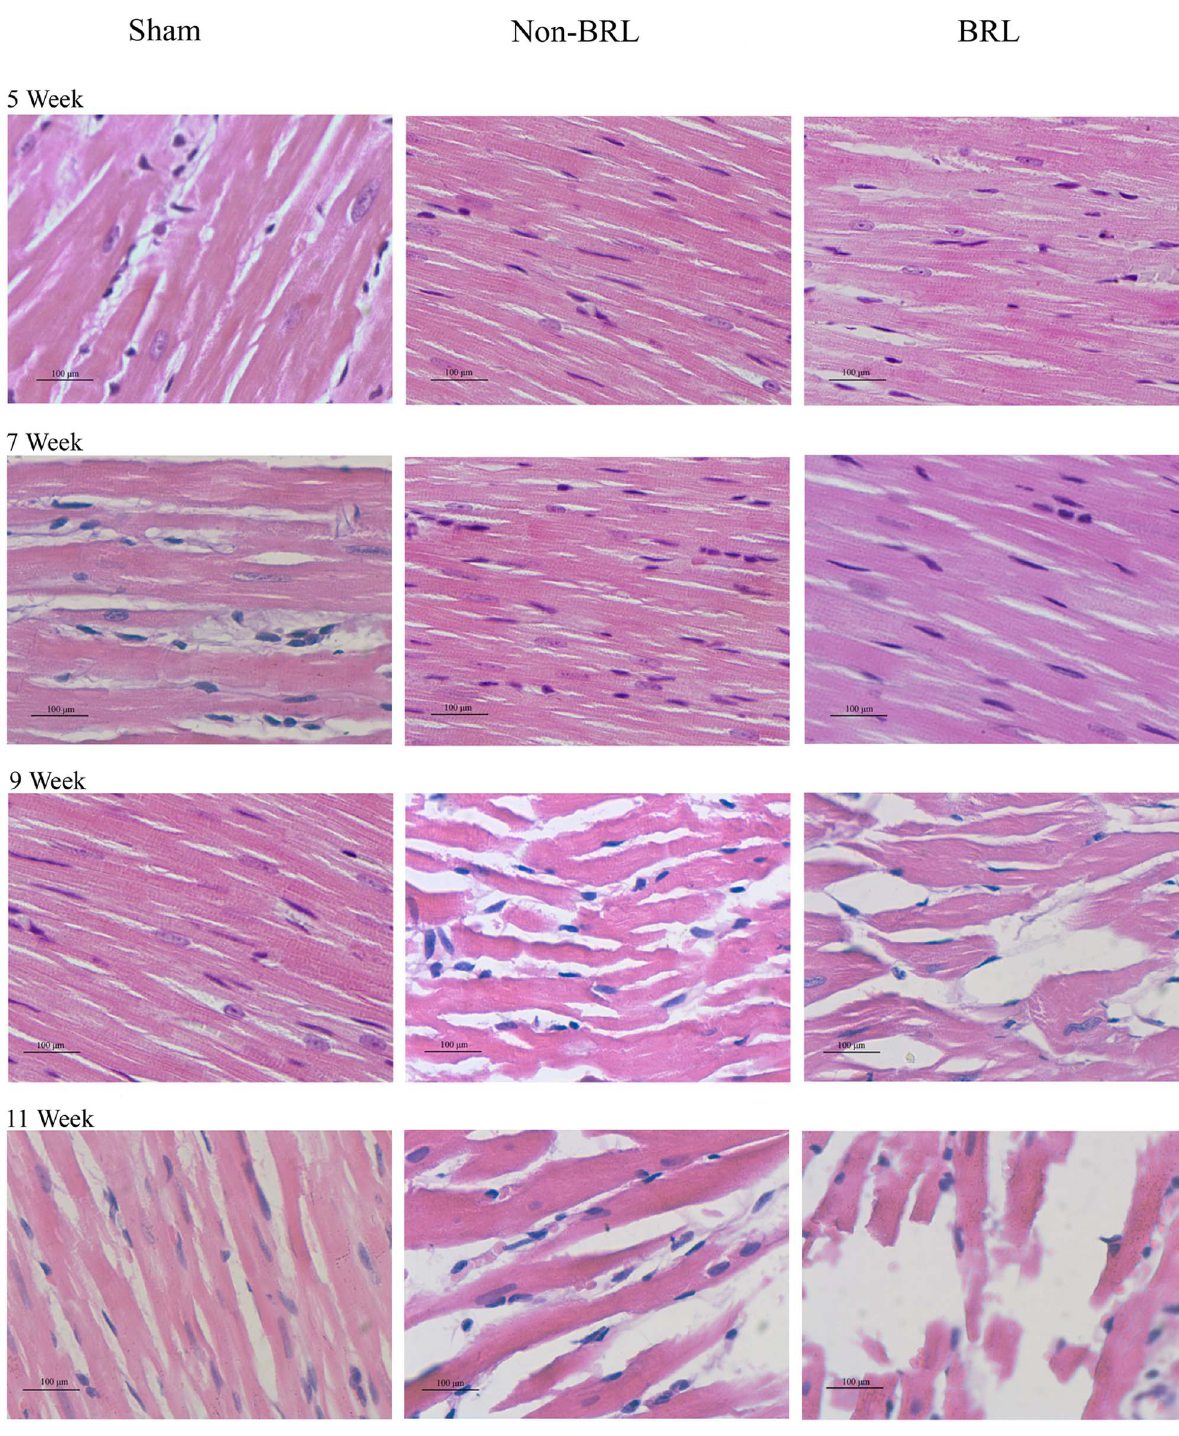
Figure 3. Cardiac histopathology at different times and in different groups. Representative images of myocardial cells at the 5 th , 7 th , 9 th , and 11 th week [observed with a Brightfield microscope under 40 6 magnification (Olympus BX 51, Japan) were presented. During the 5–7 th week after operation, the myocardial cells revealed an ordered arrangement and normal intercellular space without nuclear degeneration. However, at the 9 th week, the time-dependent increase of interstitial fibrosis, edema, degeneration, necrosis, and myocyte hypertrophy was observed in the BRL group when compared to the Banded group. BRL group: HF group with b 3 -AR agonist BRL37344 injection; non-BRL: HF group without BRL37344 injection.